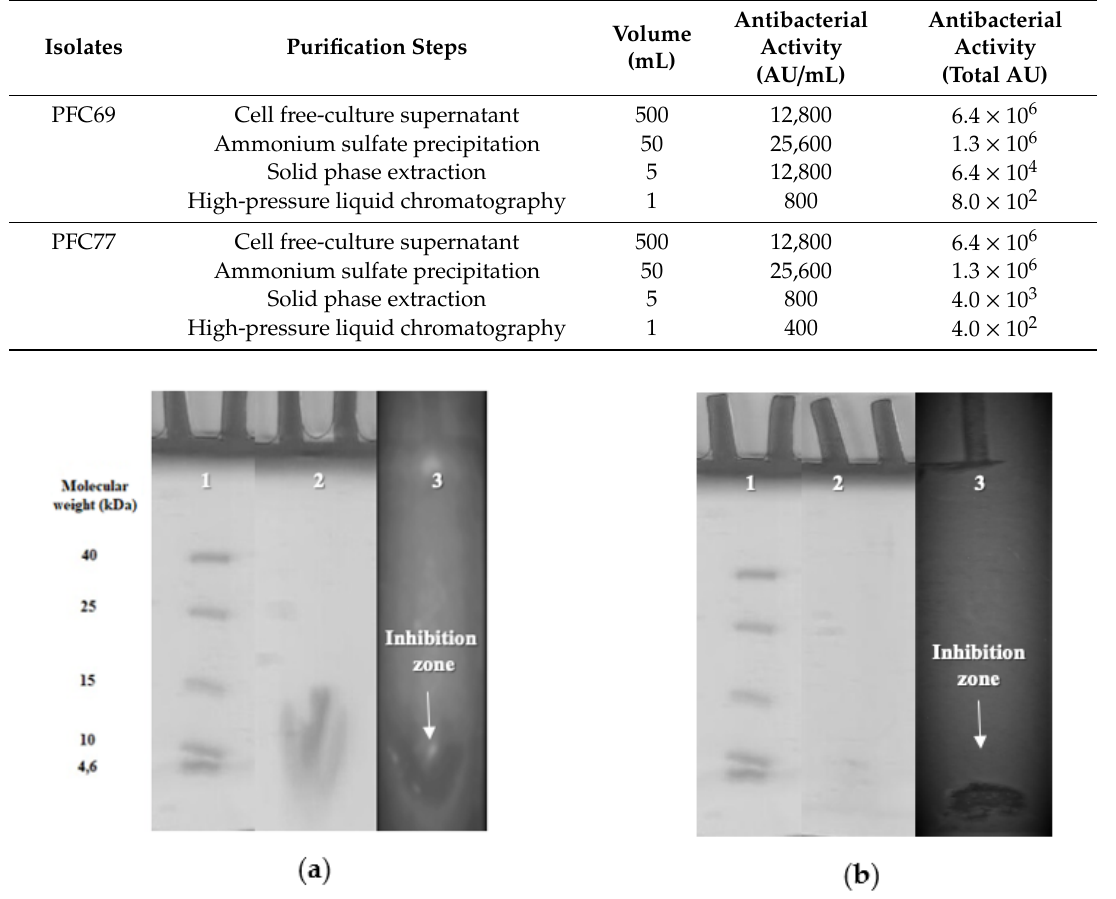
Figure 1. Tricine-SDS-PAGE profile of bacteriocins; ( a ) PFC69 and ( b ) PFC77. Lines: (1) marker, (2) bacteriocin, (3) inhibition zone.